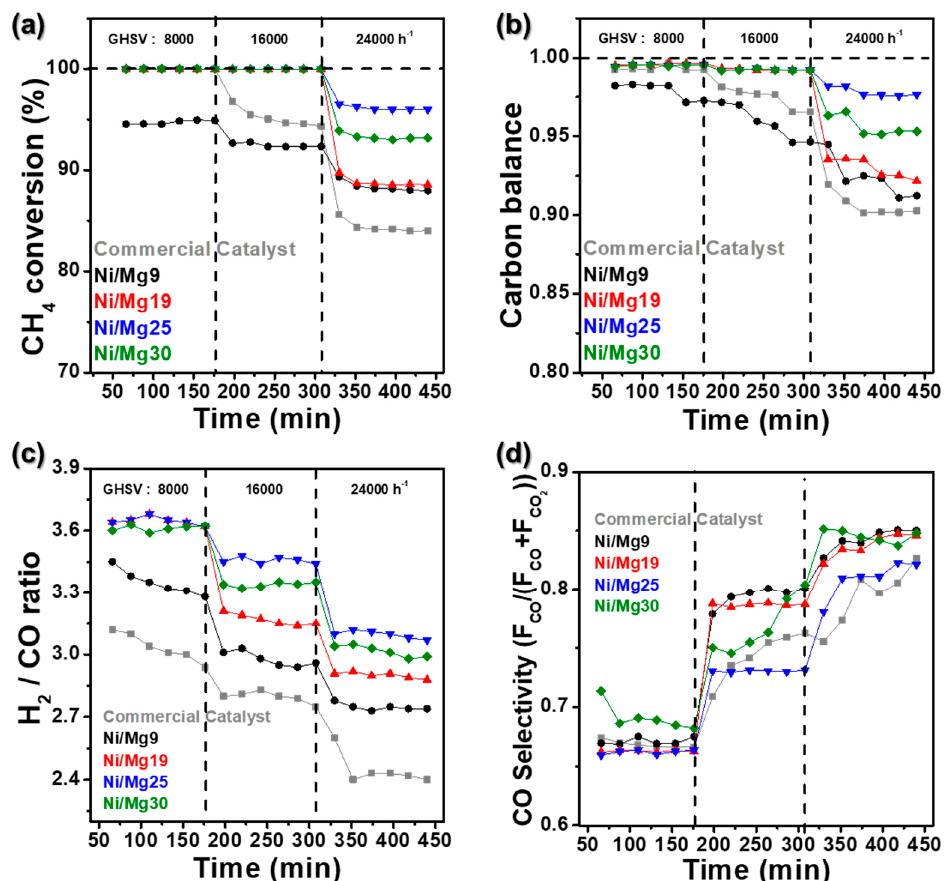
Figure 6. Time-on-stream result of SMR reaction with Ni/Mg-aluminate catalysts and commercial catalyst at 800 °C with different GHSV of 8000, 16,000, 24,000 h − 1 : ( a ) CH 4 conversion, ( b ) carbon balance, ( c ) H 2 /CO ratio, and ( d ) CO selectivity.